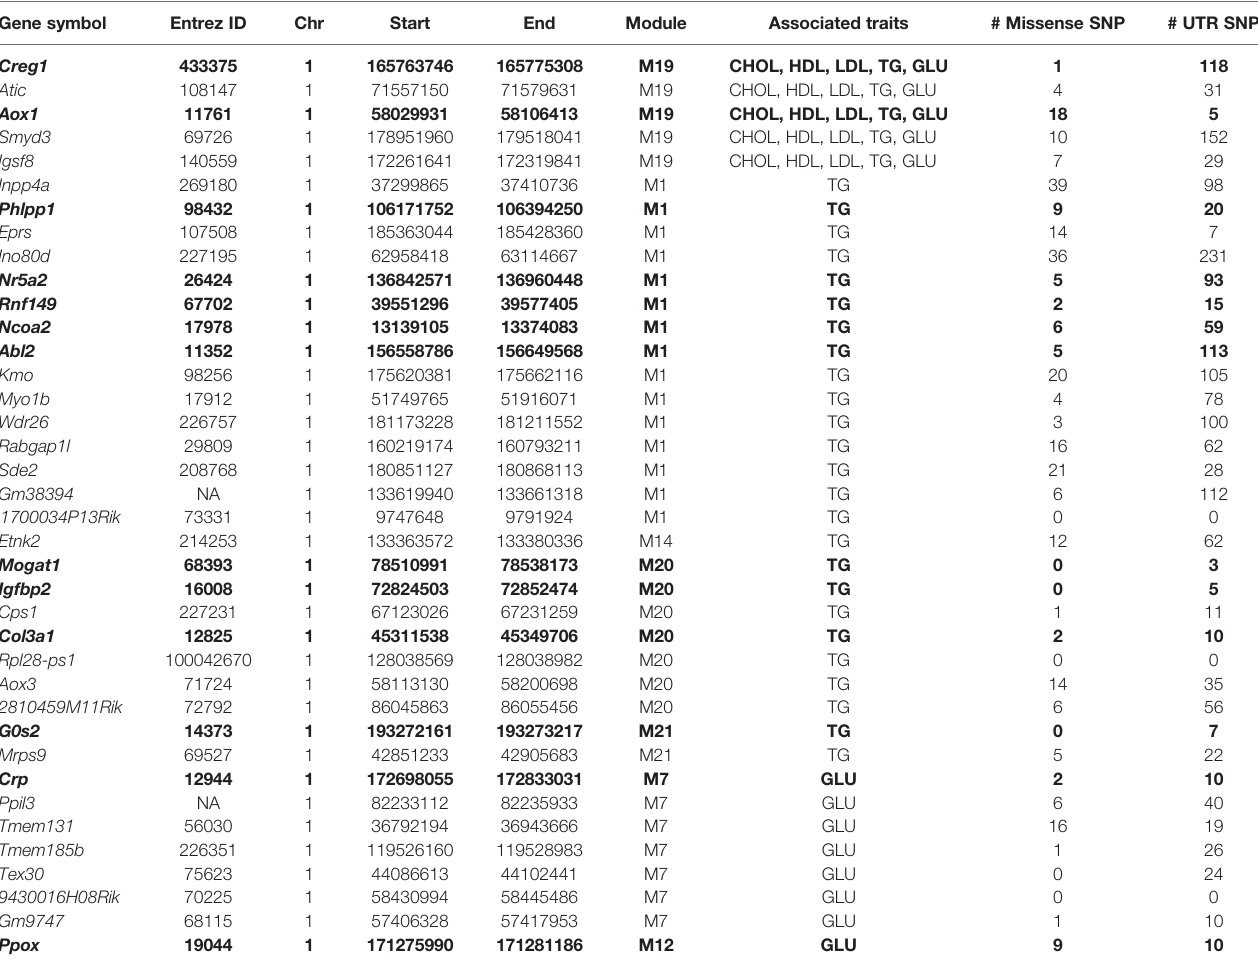
Bold highlighted genes are known functional